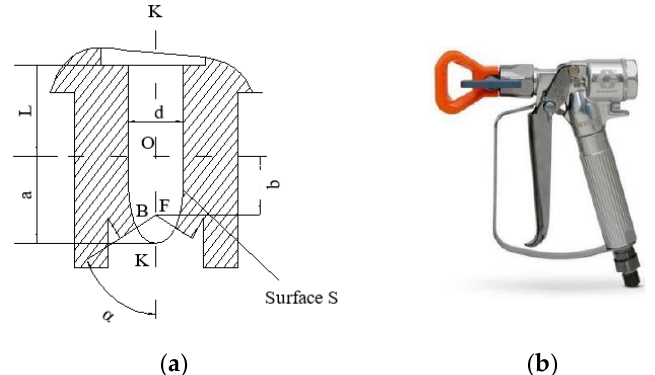
Figure 6. Nozzle inner chamber exit section structure. ( a ): Structure diagram; ( b ): Physical